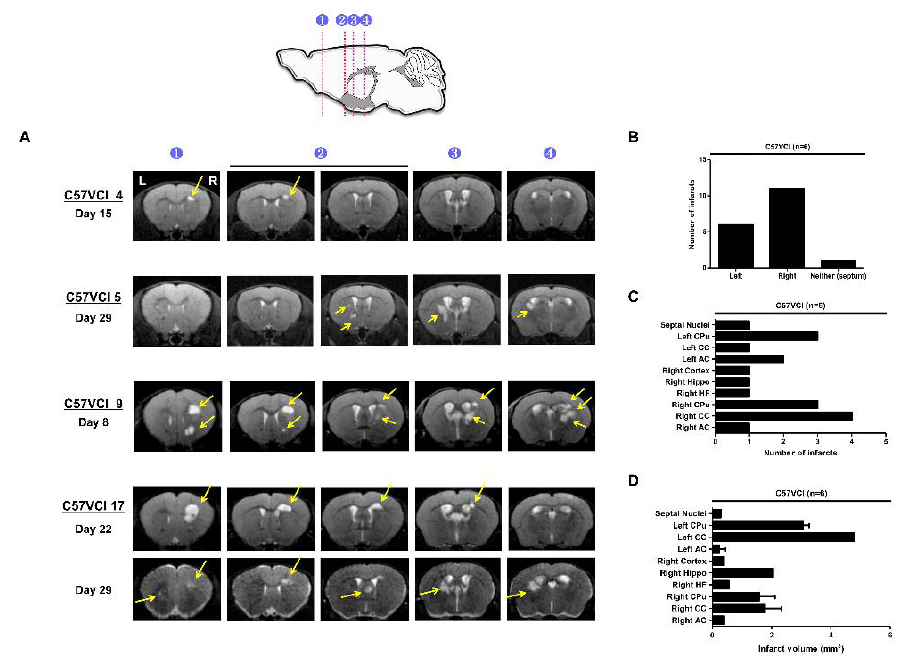
Figure 1. Variation in appearance and volume of cerebral infarcts of the C57VCI mice. ( A ) T2 weighted MR images of 4 C57 mice subjected to VCI (top to bottom: C57VCI 4, 5, 9, 17). Cerebral infarcts appeared at 4 di ff erent time points (Day 15, 22, 8, and 29, respectively) for each of the mice. Hyperintense signals (solid yellow arrows) indicate the location of infarcts. L indicates left and R indicates the right hemisphere of the mouse brain. The numbers on the sagittal section of the mouse brain (top illustration) indicate the localization of cerebral infarcts in representative areas of the C57VCI parenchyma: (1) forceps minor (2) external capsule of the corpus callosum (3) caudate putamen, and (4) hippocampal fimbria. ( B ) Total number of infarcts observed from 6 of the 17 C57VCI mice (C57VCI 4, 5, 9, 15, 16, 17). ( C ) Distribution of infarcts. CC = corpus callosum, CPu = caudate putamen, AC = anterior commissure, Hippo = hippocampus, and HF = hippocampal fimbria. ( D ) Volume of the cerebral infarcts (mm 3